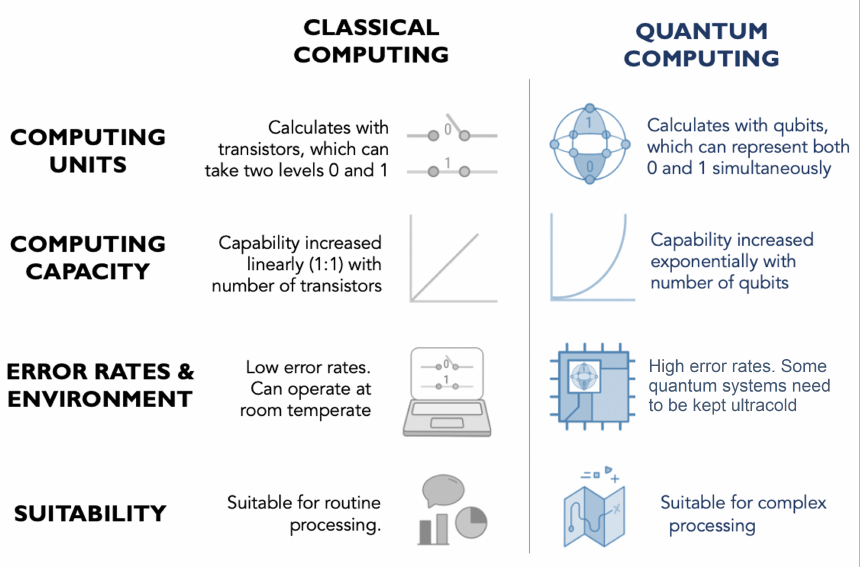
Figure 1. Comparison of Classical Computing vs. Quantum Computing in terms of four key attributes: (1) computing units; (2) computing capacity; (3) suitability; and (4) and error